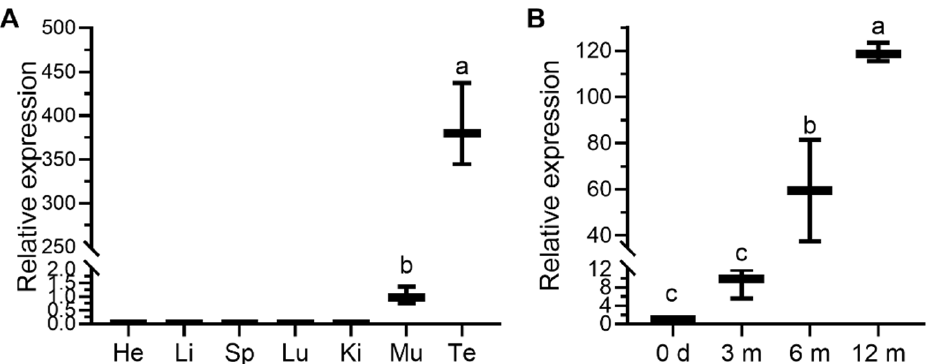
Figure 5. Relative expression levels of the PRAMEY mRNA in Hu sheep were detected by qPCR. ( A ) The expression level of PRAMEY in seven different tissues at 6 months old. PRAMEY was expressed mainly in testis and slightly in muscle. He: heart; Li: liver; Sp: spleen; Lu: lung; Ki: kidney; Mu: muscle; Te: testis. ( B ) mRNA expression abundance of PRAMEY at different developmental stages of testis. The expression of PRAMEY mRNA was expressed very low at 0 days and 3 months but significantly upregulated at 6 and 12 months. Values are means ± SD of three biological replicates ( n = 3). Different letters above error bars indicate significant differences, p ≤ 0.05.